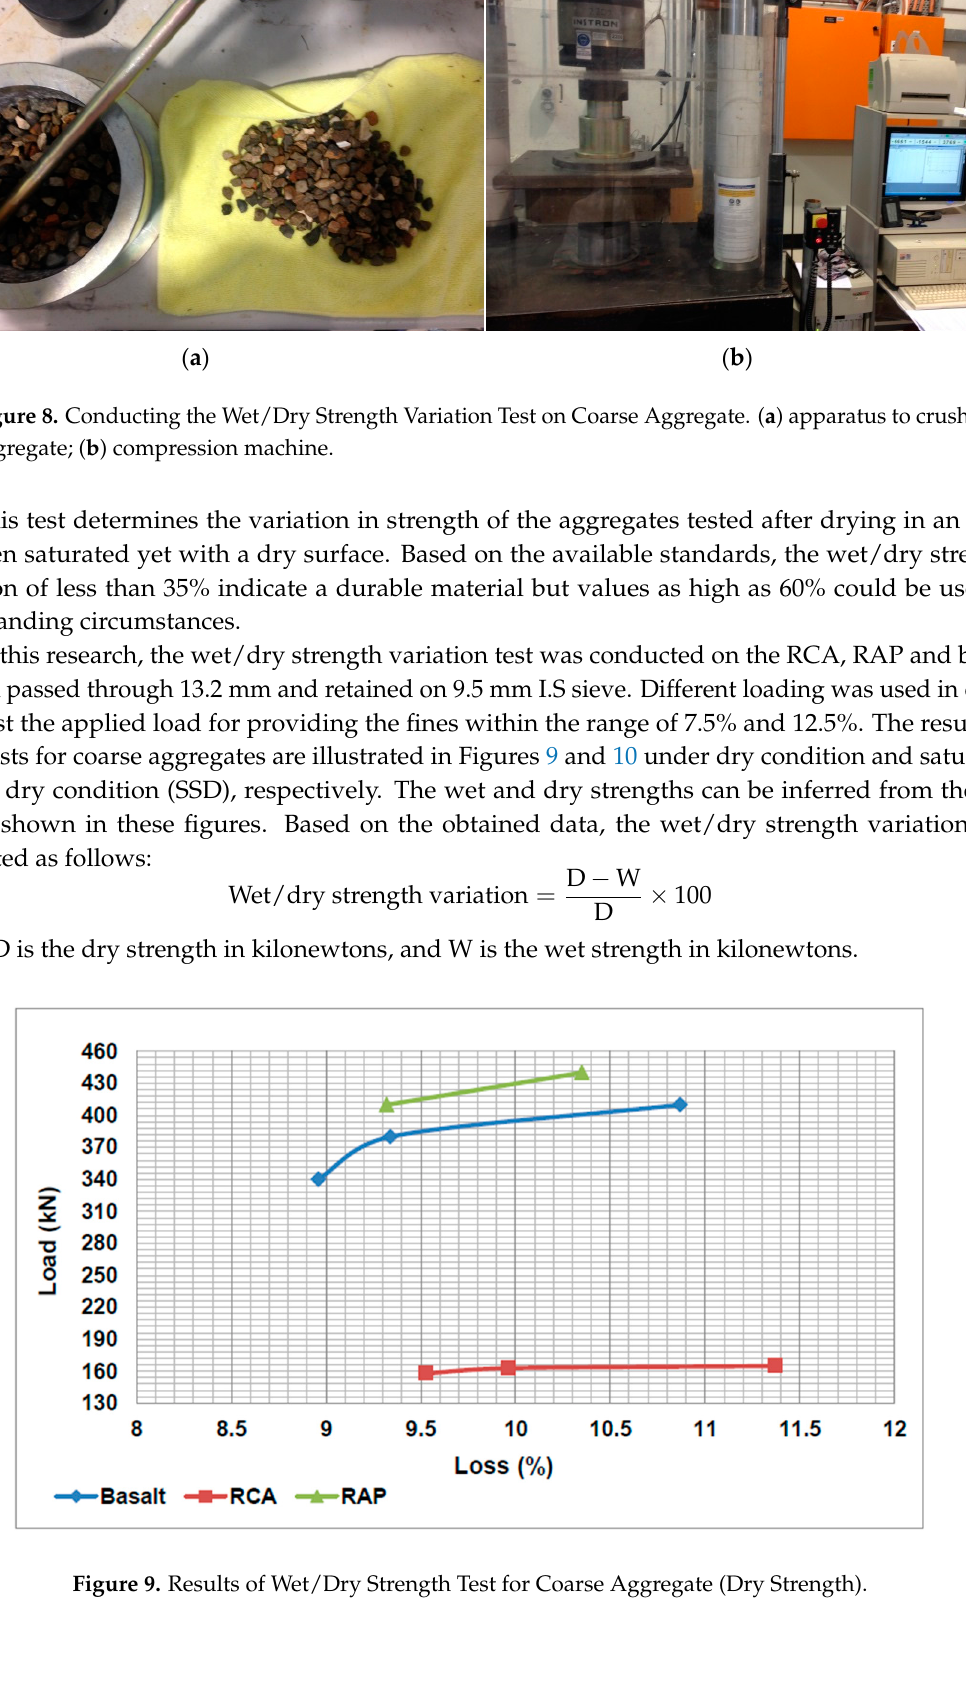
Figure 10. Results of Wet/Dry Strength Test for Coarse Aggregate (Wet Strength). Table 8. The Results of Wet/Dry Strength Variation Test for Aggregates and Strength Limits for Dense Graded Asphalt Based on Australian Standards. Material